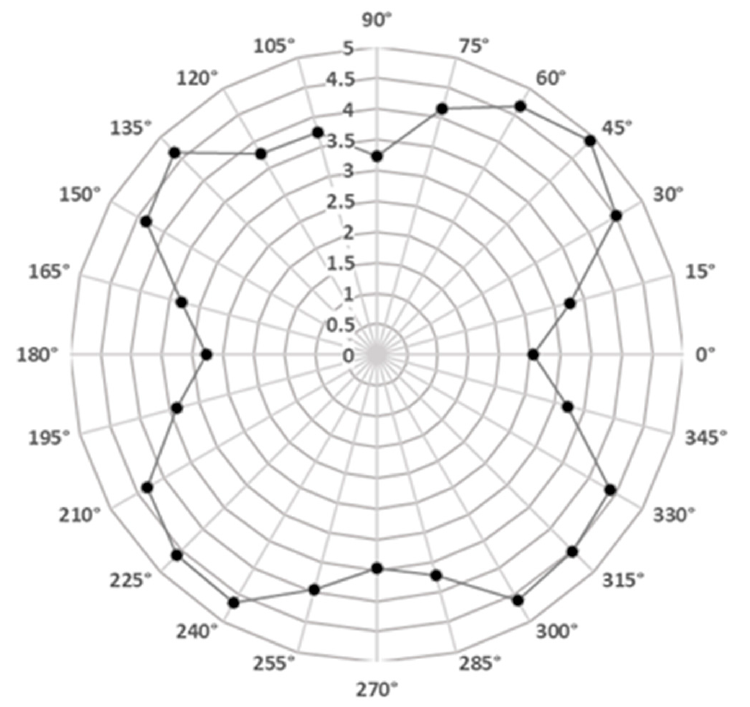
Figure 5. Relationship between tracking direction and MT.